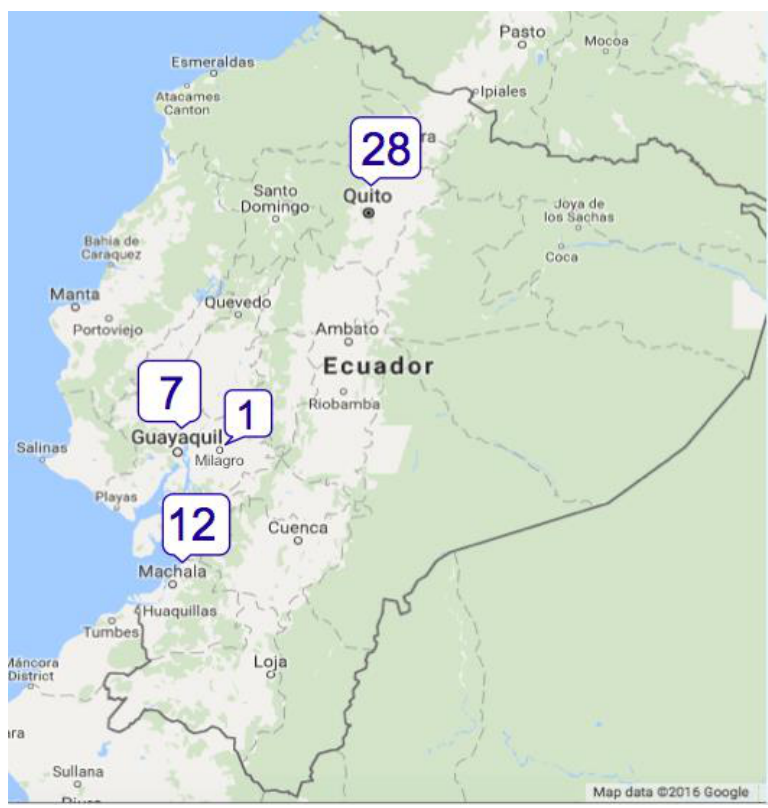
Figure 2. Interview locations in Ecuador. Numbers indicate number of sex workers interviewed in each city. Map from Google Maps , edited to include Milagro.